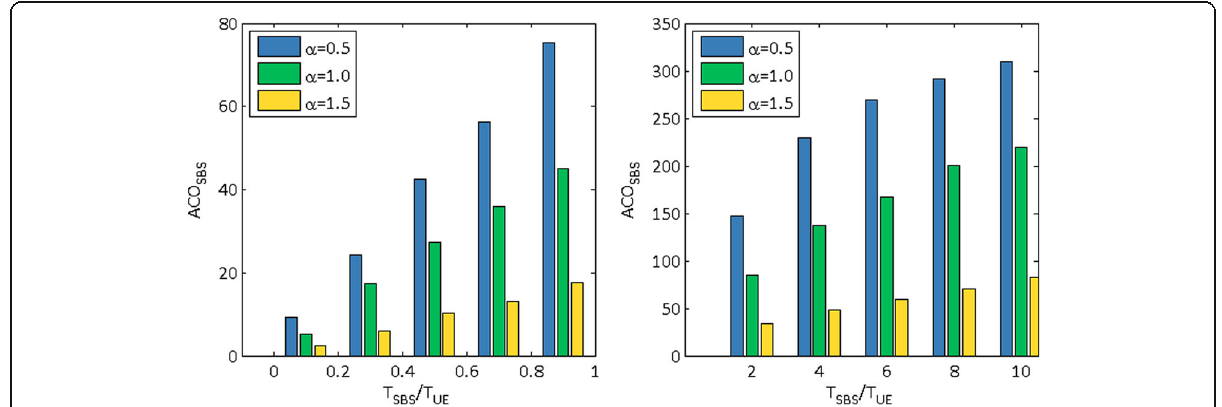
α in the SBS level ( d